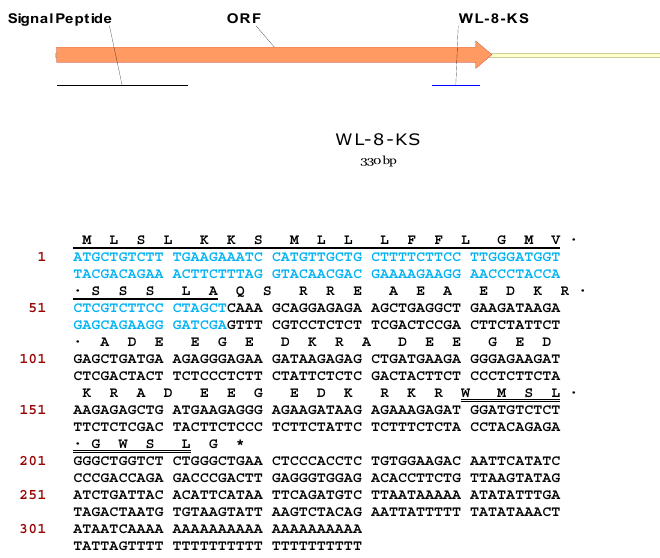
Figure 3. Nucleotide and translated open-reading frame amino acid sequence of full-length cDNA encoding a single copy of WL-8. The putative signal peptide (blue colour and single-underlined), the mature encoding sequence (double-underlined) and the stop codon (asterisk) are indicated.